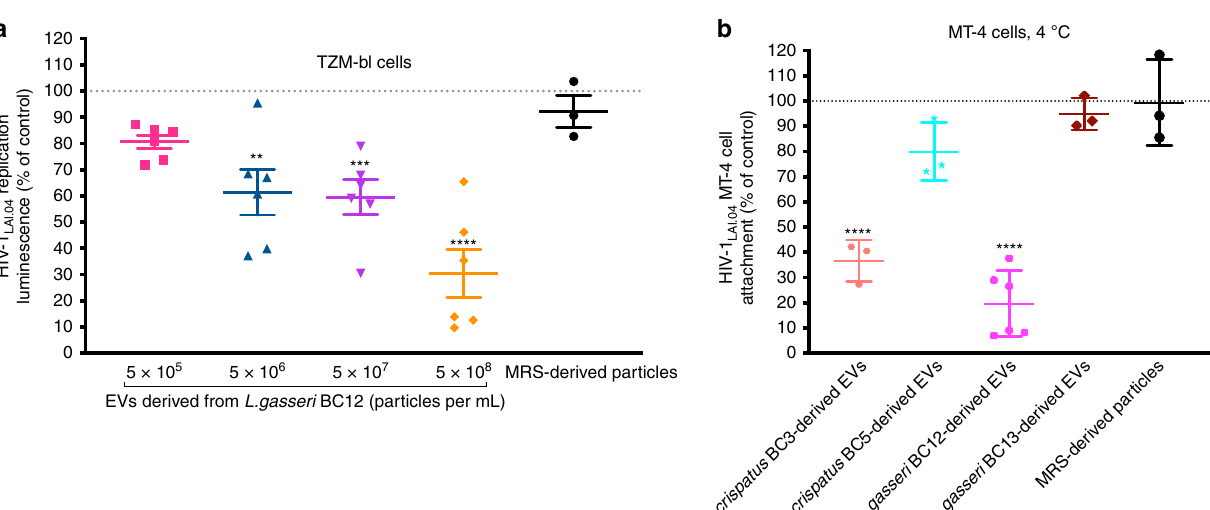
Fig. 5 Effect of Lactobacillus -derived EVs on HIV-1 entry/attachment to the target cell. a TZM-bl cells were cultured in an EV – HIV-1 mixture overnight and then continued to be cultured in the presence of EVs from L. gasseri BC12 at different concentrations or particles derived from MRS medium for 3 days. To measure the HIV-1 LAI.04 integration, we removed the cell culture medium, lysed the cells, added substrate, and measured the luminescence. b MT-4 cells were treated for 2 h with a mixture of HIV-1 LAI.04 and EVs derived from four Lactobacillus strains ( L. crispatus BC3, L. crispatus BC5, L. gasseri BC12,